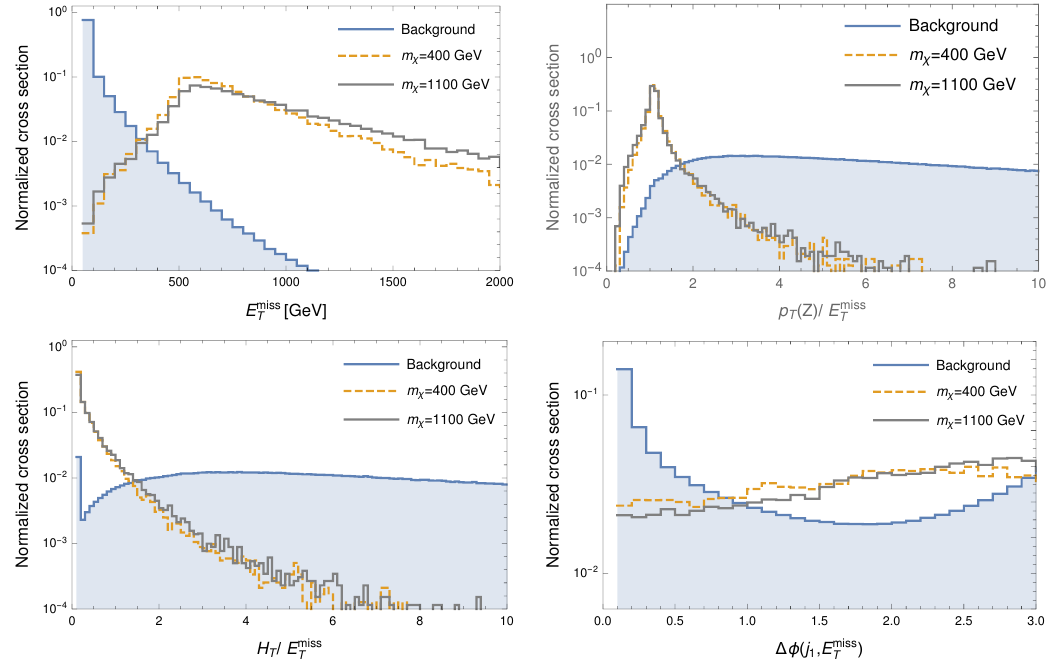
Figure 4 . Unit-normalized kinematic distributions after preselection for signal points with masses 1.1 TeV (solid) and 400 GeV (dashed), and nominal charged-neutral splitting, and the sum of the three leading backgrounds (shaded) ( Z +jets, ZZ ! l + l (cid:0) jj and WZ ! ‘ + ‘ (cid:0) ‘(cid:23) ).